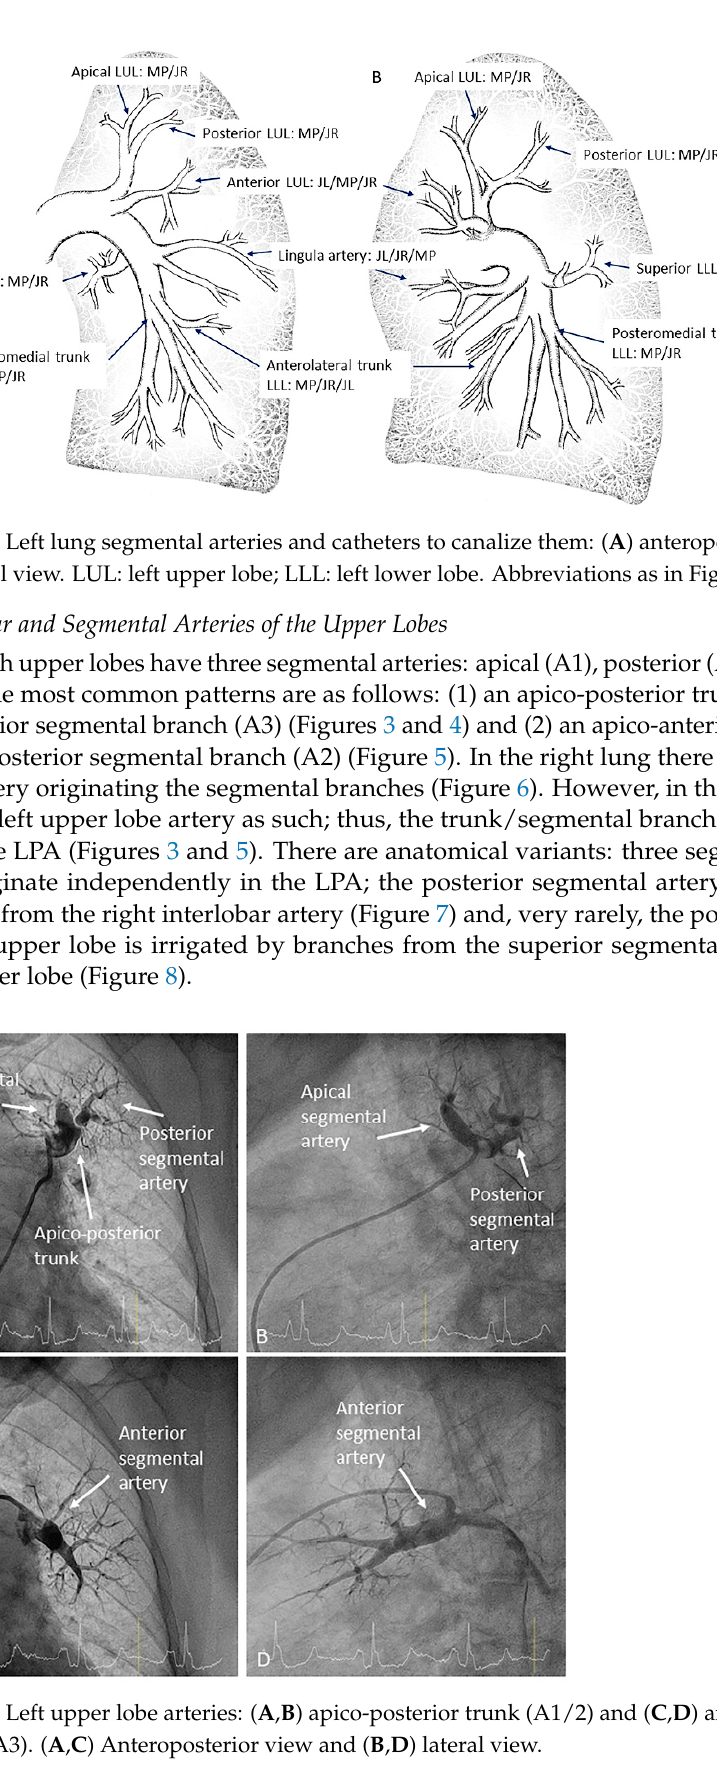
Figure 1. Right lung segmental arteries and catheters to canalize them: ( A ) anteroposterior view and ( B ) lateral view. JR: Judkins right; MP: multipurpose; RUL: right upper lobe; RLL: right lower lobe.